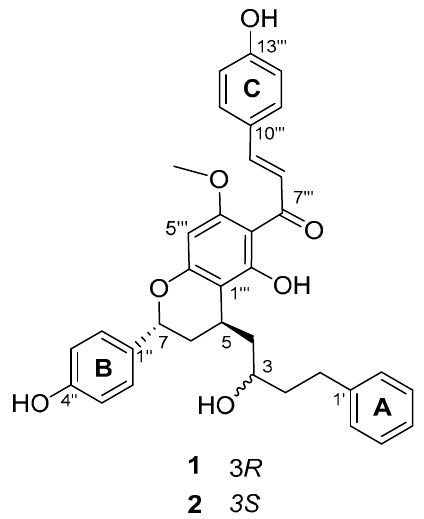
Figure 1. Chemical structures of compounds 1 and 2 from the seeds of A. katsumadai .